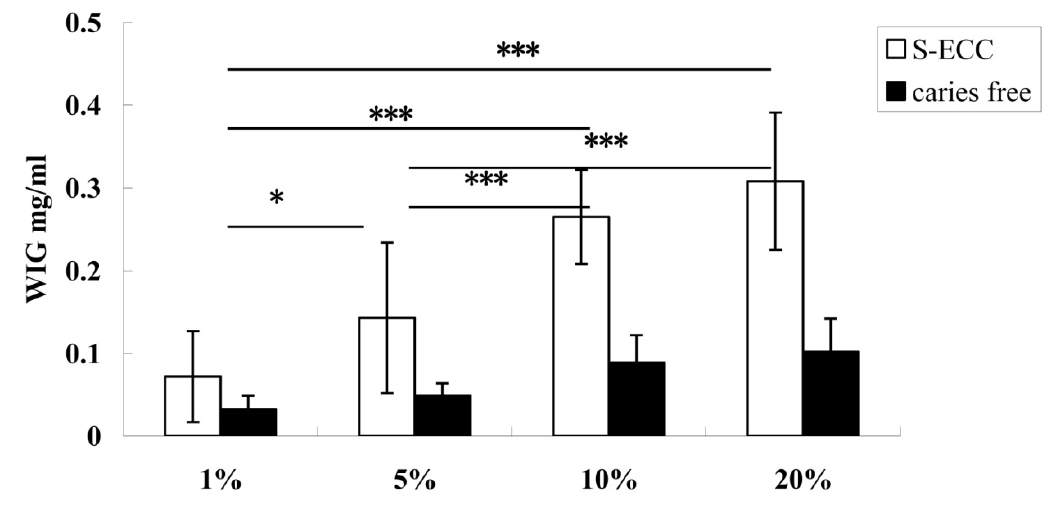
Figure 1. WIG synthesis of S. mutans from children with ECC and caries-free children with 1%, 5%, 10%, and 20% sucrose. White bars and black bars represent the means (with standard deviations) of WIG synthesized by S. mutans isolated from children with ECC and caries-free children. * Denotes statistical significance ( p < 0.05), and *** Denotes statistical significance ( p < 0.001).